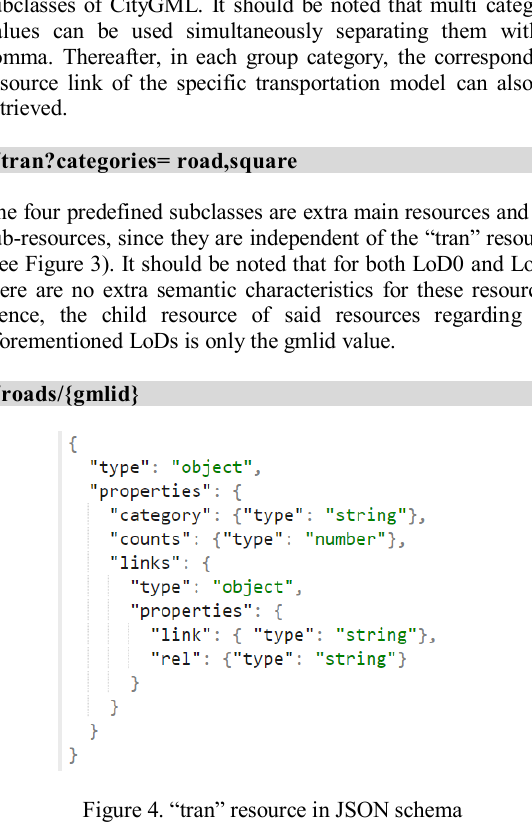
Figure 3. Extra main resources Figure 4. “tran” resource in JSON